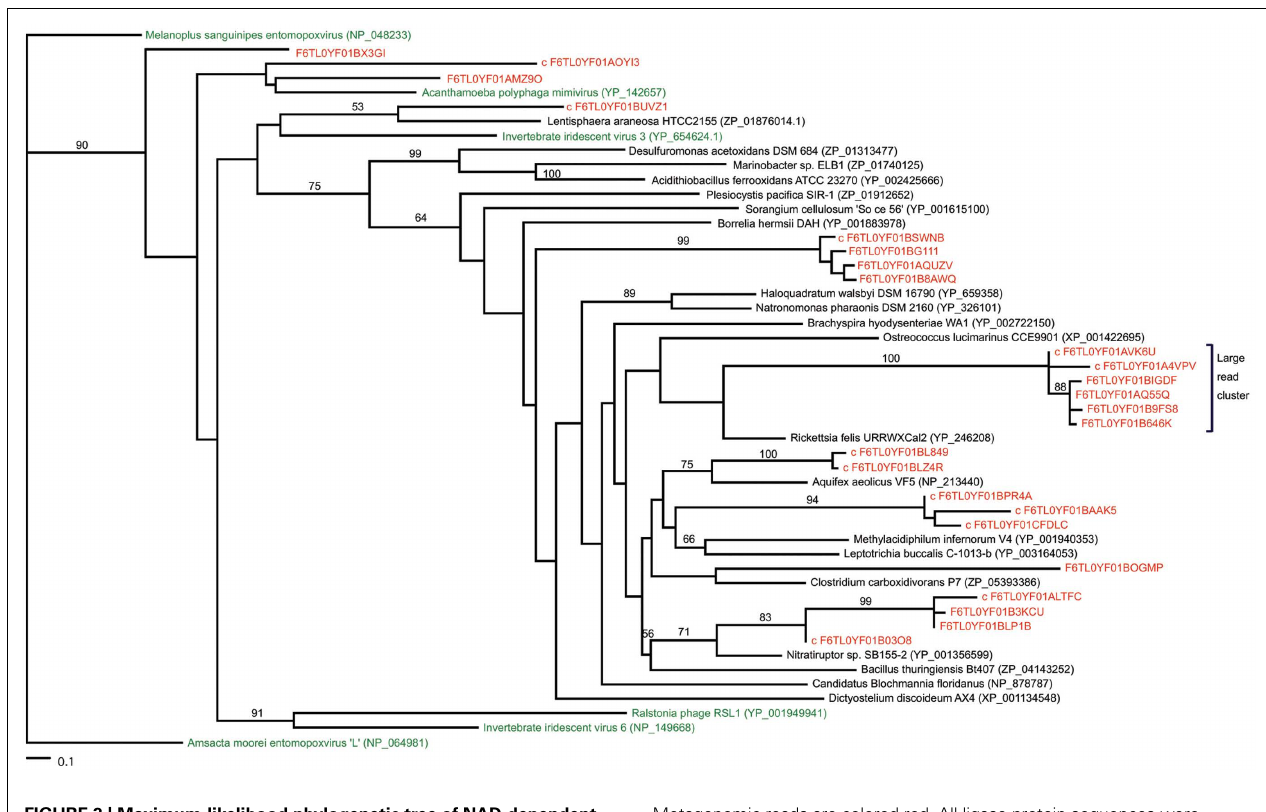
FIGURE 3 | Maximum-likelihood phylogenetic tree of NAD-dependent DNA ligases with metagenomic reads from the marine vent virome. The “large read cluster” denotes the branch in which the majority of metagenomic reads matching ligases grouped on the tree. Numbers indicate the bootstrap values of internal nodes (where n =